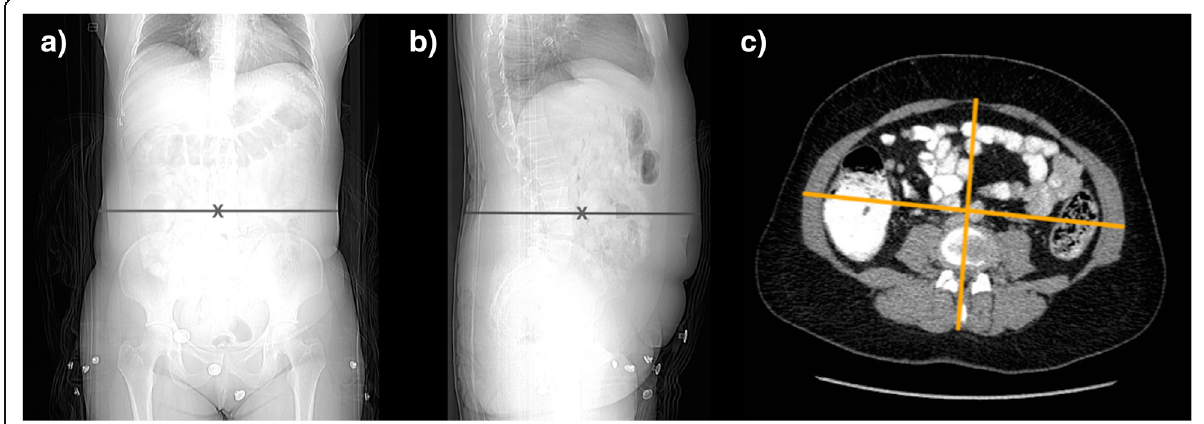
Fig. 1 Measurement of lateral ( D LAT ) ( a ) anteroposterior ( D AP ) ( b ) skin-to-skin patient diameters at the midslice level on CT-localiser images. Measurement of the inner lateral and anteroposterior diameters on the axial midslice CT image excluding the subcutaneous adipose tissue ( c ) to allow calculation of the effect inner diameter ( D IN ) and the effective diameter ratio ( D RATIO